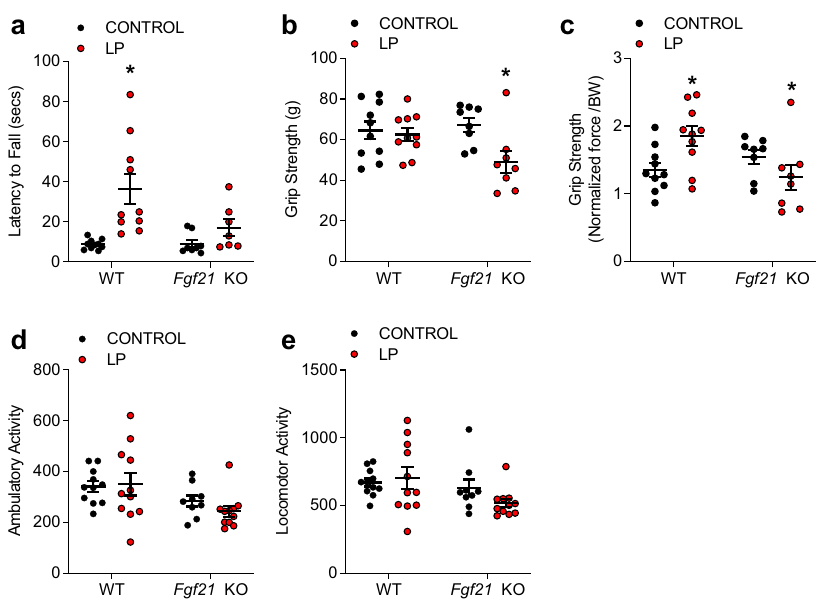
Fig. 3 Protein restriction protects against age-related functional decline via FGF21. a Latency to fall from an accelerating rod (Rotarod) at 21 months of age in WT and Fgf21 KO mice on control or LP diets ( n = 8 – 12 mice/group; geno*diet p = 0.008). b Grip Strength at 21 months of age ( n = 8 – 12 mice/ group; geno*diet p = 0.04). c Grip Strength normalized to body mass ( n = 8 – 12 mice/group; geno*diet p = 0.01). d Ambulatory activity as measured in the metabolic chambers at 20 months of age ( n = 8 – 12 mice/group geno*diet p = 0.39). e Locomotor activity as measured in the metabolic chambers at 20 months of age ( n = 8 – 12 mice/group geno*diet p = 0.19). Statistical analyses were conducted using two-way ANOVA. All values are mean ± SEM, with signi fi cant posthoc comparison within the diet*genotype interaction noted as * p < 0.05 compared with respective control. Source data are provided as a Source Data fi